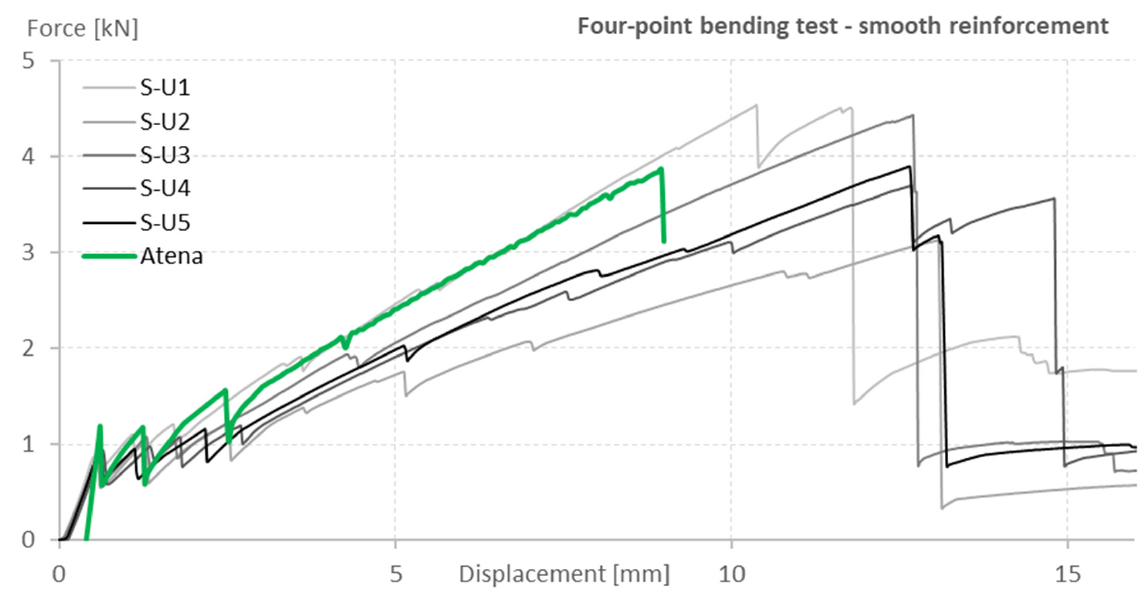
Figure 3. Load ‐ displacement diagram comparison of the four ‐ point bending test of specimens with smooth reinforcement and the numerical model prediction.